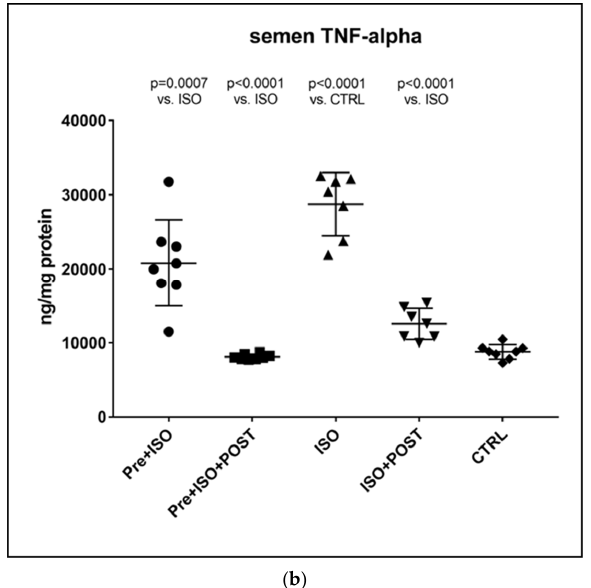
Figure 3. ( a ) The effects of isoproterenol treatment and exercise training on interleukin-6 (IL-6) con- centrations of the semen, expressed as ng/mg protein. ( b ) The effects of isoproterenol treatment and